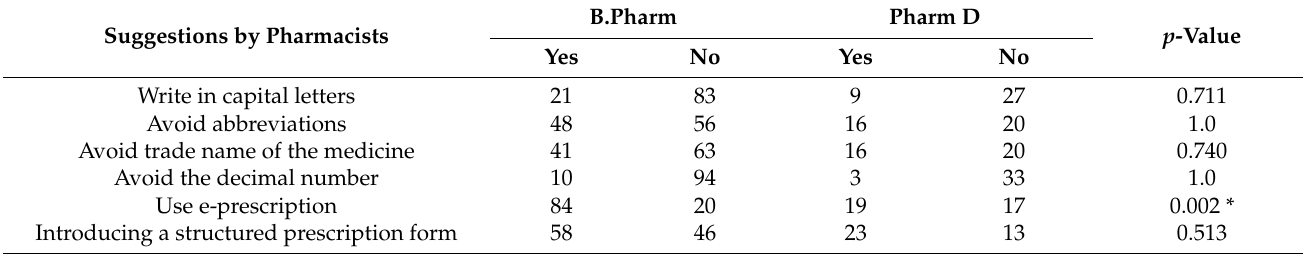
Table 4. Comparison between the educational degree of the pharmacists and their suggestions to improve the prescriptions. Suggestions by